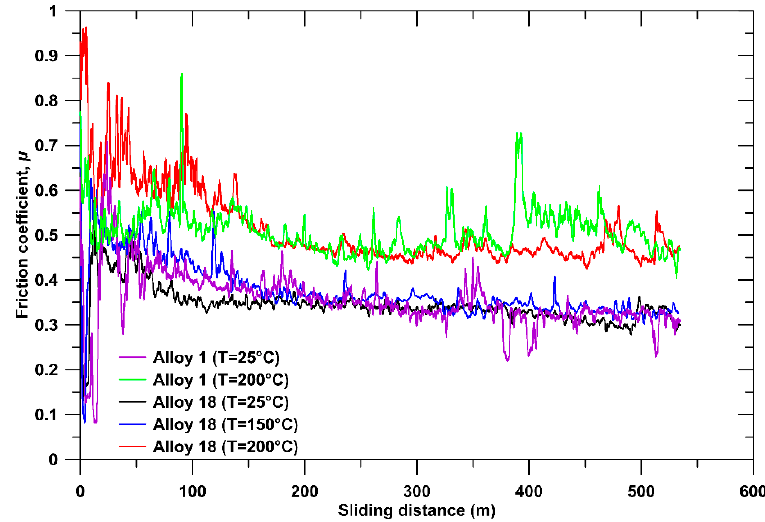
Figure 12. Effects of Fe, Mn, and Cr additions and test temperature on the friction coefficient at constant sliding distance. Alloys 1 (SF = 1.32) and 18 (SF = 2.90) with the lowest and highest sludge factors are taken as references.